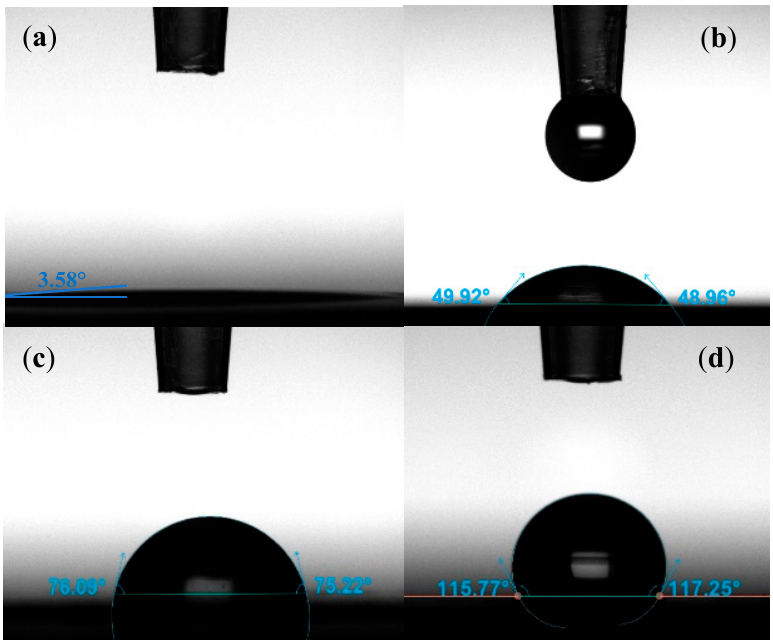
Figure 2. Shapes of water droplets and contact angle on modified stainless steels with different wettability.